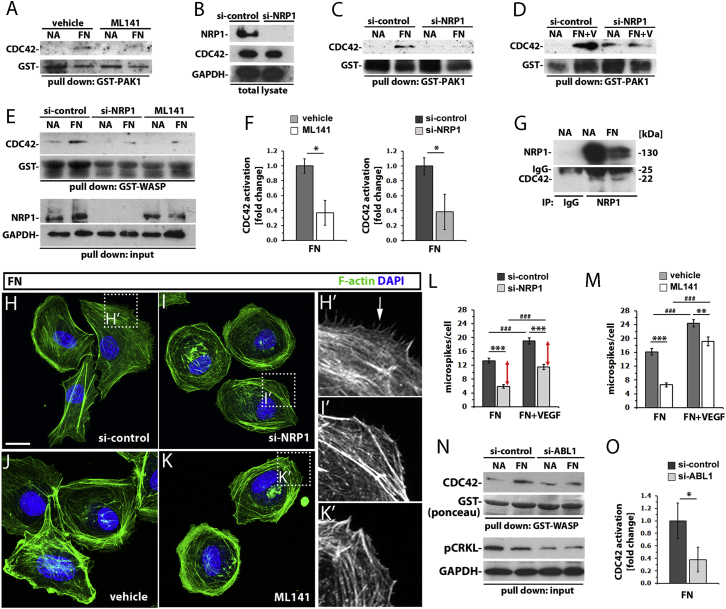
NRP1 Is Required for Normal CDC42 Activation, and CDC42 or NRP1 Knockdown Similarly Impairs Actin Remodeling in Primary Human ECs(A–E) NRP1 enables ECM-induced CDC42 activation. HDMECs were serum-starved and treated with vehicle or ML141 for 30 min (A and E) or transfected with si-control or si-NRP1 and serum starved (B–E); protein lysates of non-adherent (NA) cells or adherent cells after 30 min on FN were incubated with PAK1-GST (A, C, and D) or WASP-GST (E, top) beads and immunoblotted or used directly for immunoblotting (B and E, bottom). In (D), HDMECs were additionally stimulated for 15 min with 5 ng/ml VEGF165 (FN+V).(F) Impaired CDC42 activation after ML141 treatment or NRP1 knockdown in ECM-stimulated ECs. Activated CDC42 was normalized to GST input and expressed as mean fold change relative to control ± SD; n = 3; asterisks indicate ∗p < 0.05.(G) Complex formation of endogenous NRP1 and CDC42 in ECs. Lysates from NA and FN-adherent HDMECs were immunoprecipitated with control immunoglobulin G (IgG) or NRP1 antibody, followed by immunoblotting for NRP1 and CDC42. The 25-kDa IgG band is indicated.(H–M) NRP1 and CDC42 are required for ECM-induced actin remodeling in ECs. After transfection with control versus NRP1 si-RNA or treatment with vehicle versus ML141, HDMECs were detached, plated on FN for 2 hr, and stained with phalloidin to label F-actin and DAPI to visualize cell nuclei. Scale bar, 20 μm. Higher-magnification images of the boxed areas in (H, I, and K) are shown in (H′), (I′), and (K′). Microspike quantitation after NRP1 knockdown (L) or CDC42 inhibition (M) and plating for 1 hr on FN, shown as mean microspike number per cell ± SEM; n ≥ 42 cells for each condition (asterisks indicate p values for control relative to si-NRP1- or ML141-treated cells: ∗∗p < 0.01, ∗∗∗p < 0.001; hashtags indicate p values for FN without VEGF-A stimulation [FN] relative to cells on FN with additional VEGF-A stimulation [FN+VEGF], ###p < 0.001). Red arrows indicate the similar reduction in microspikes on FN compared to FN+VEGF.(N and O) ABL1 enables CDC42 activation in ECM-stimulated ECs. After transfection with si-control or si-ABL1, lysates from NA and FN-adherent HDMECs were incubated with WASP-GST beads followed by immunoblotting (N, top) or used directly for immunoblotting (N, bottom). GST staining and GAPDH immunoblotting confirmed similar input of GST-beads and lysate. (O) Activated CDC42 was normalized to GST input and expressed as mean fold change relative to control ± SD; n ≥ 3; asterisks indicate ∗p < 0.05.